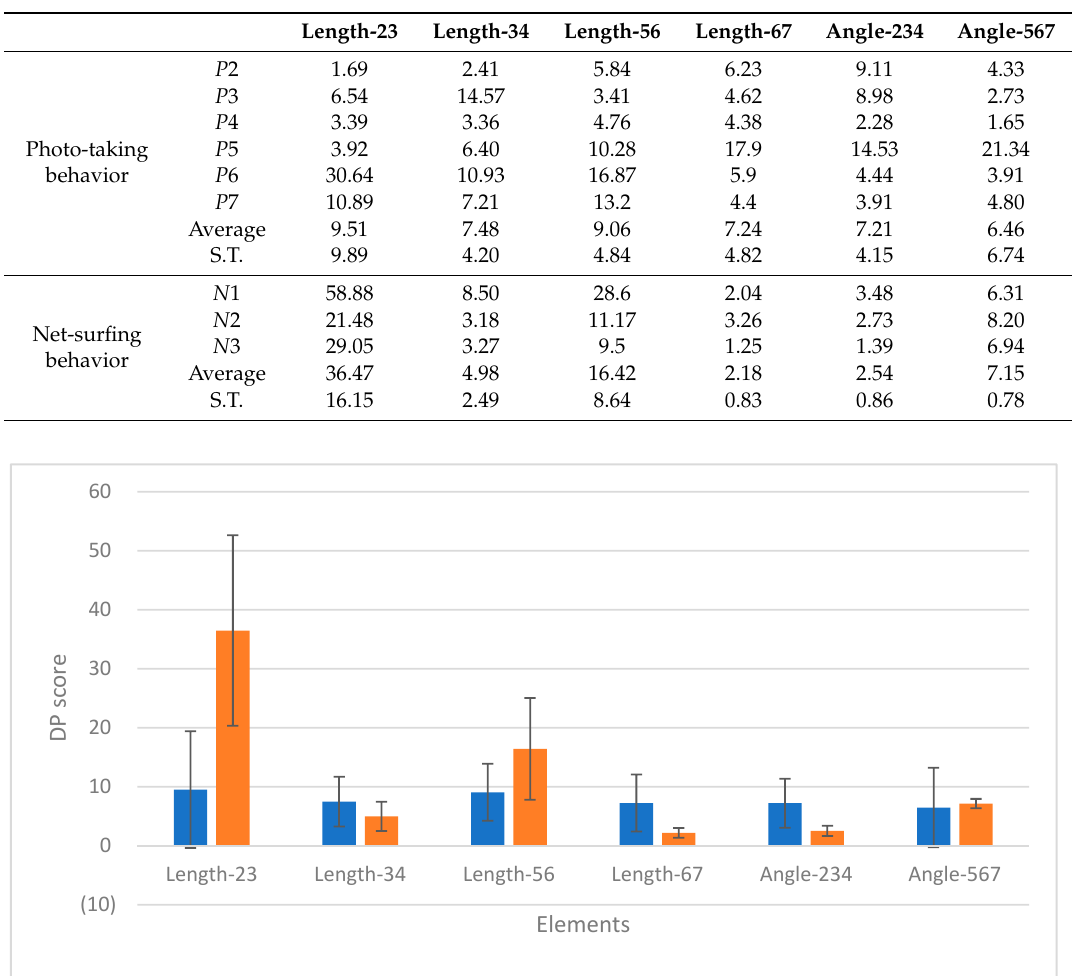
Table 3. DP scores obtained from the case where P1 was used as the reference data (Reference data: P 1,